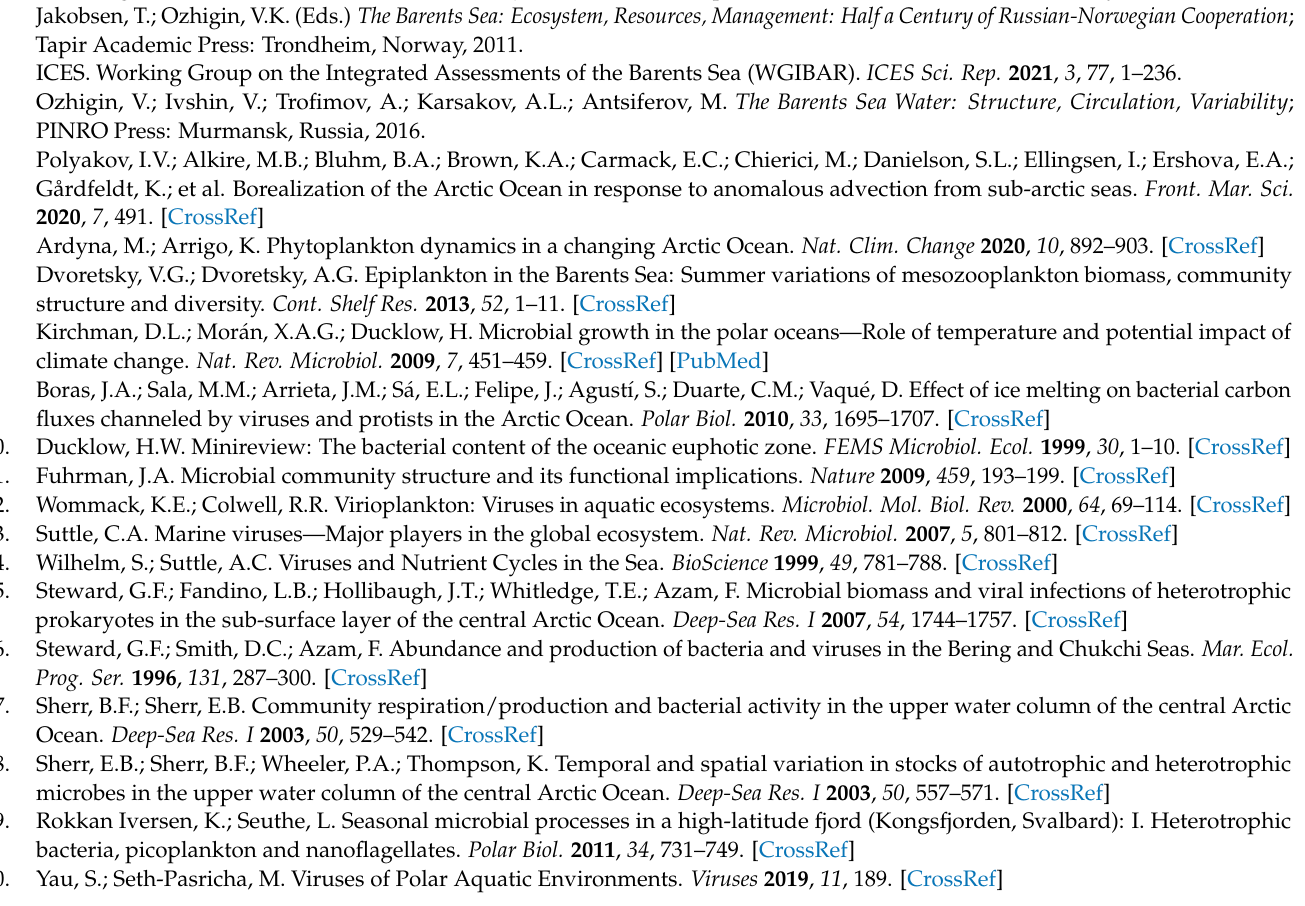
2020. R 2 —determination coefficient. N = 30. Figure S9: Relationship between R (contact rate be- tween viruses and bacteria) and water temperature in the northeastern Barents Sea, in autumn 2020. R 2 —determination coefficient. N = 30. Figure S10: Relationship between R (contact rate between viruses and bacteria) and phosphate concentration in the northeastern Barents Sea, in autumn 2020. R 2 —determination coefficient. N = 30. Figure S11: Relationship between R (contact rate between viruses and bacteria) and nitrate concentration in the northeastern Barents Sea, in autumn 2020. R 2 —determination coefficient. N =